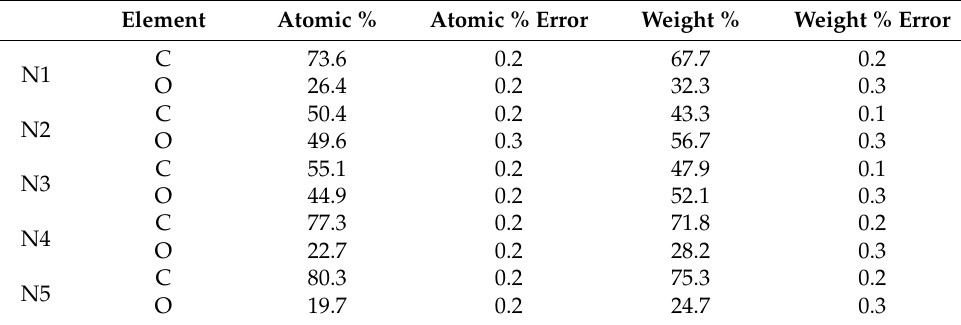
Table 3. Surface analysis of nanoencapsulates by EDS.